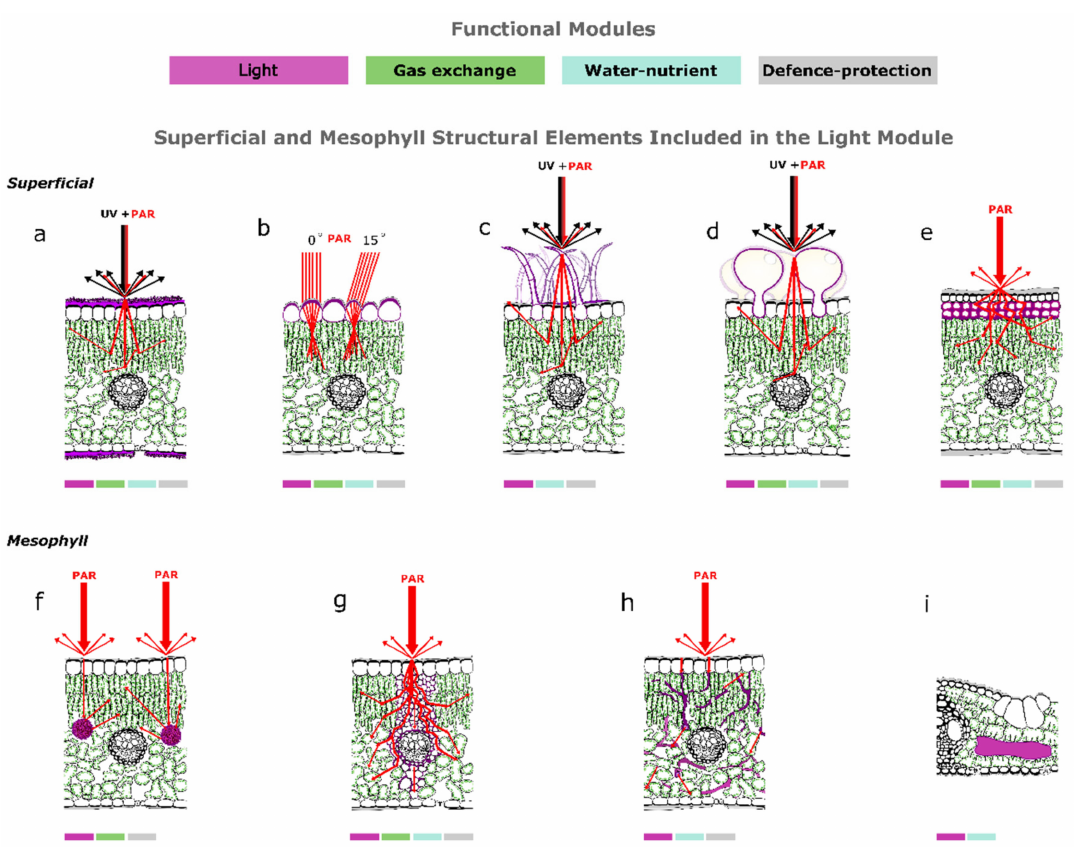
Figure 1. Conceptual representation of the optical properties of the nine ( a–i ) structural elements of leaves (typical bifacial leaves with various structural idiosyncrasies ( a – h ) and representative bamboo leaf ( i )) included in the light module: ( a ) cuticle light reflectance, ( b ) epidermal cell light focusing, ( c ) non-glandular hair light reflectance and scattering, ( d ) gland light reflectance and scattering, ( e ) multiseriate sclerified hypodermis light scattering, ( f ) crystal or cystolith light